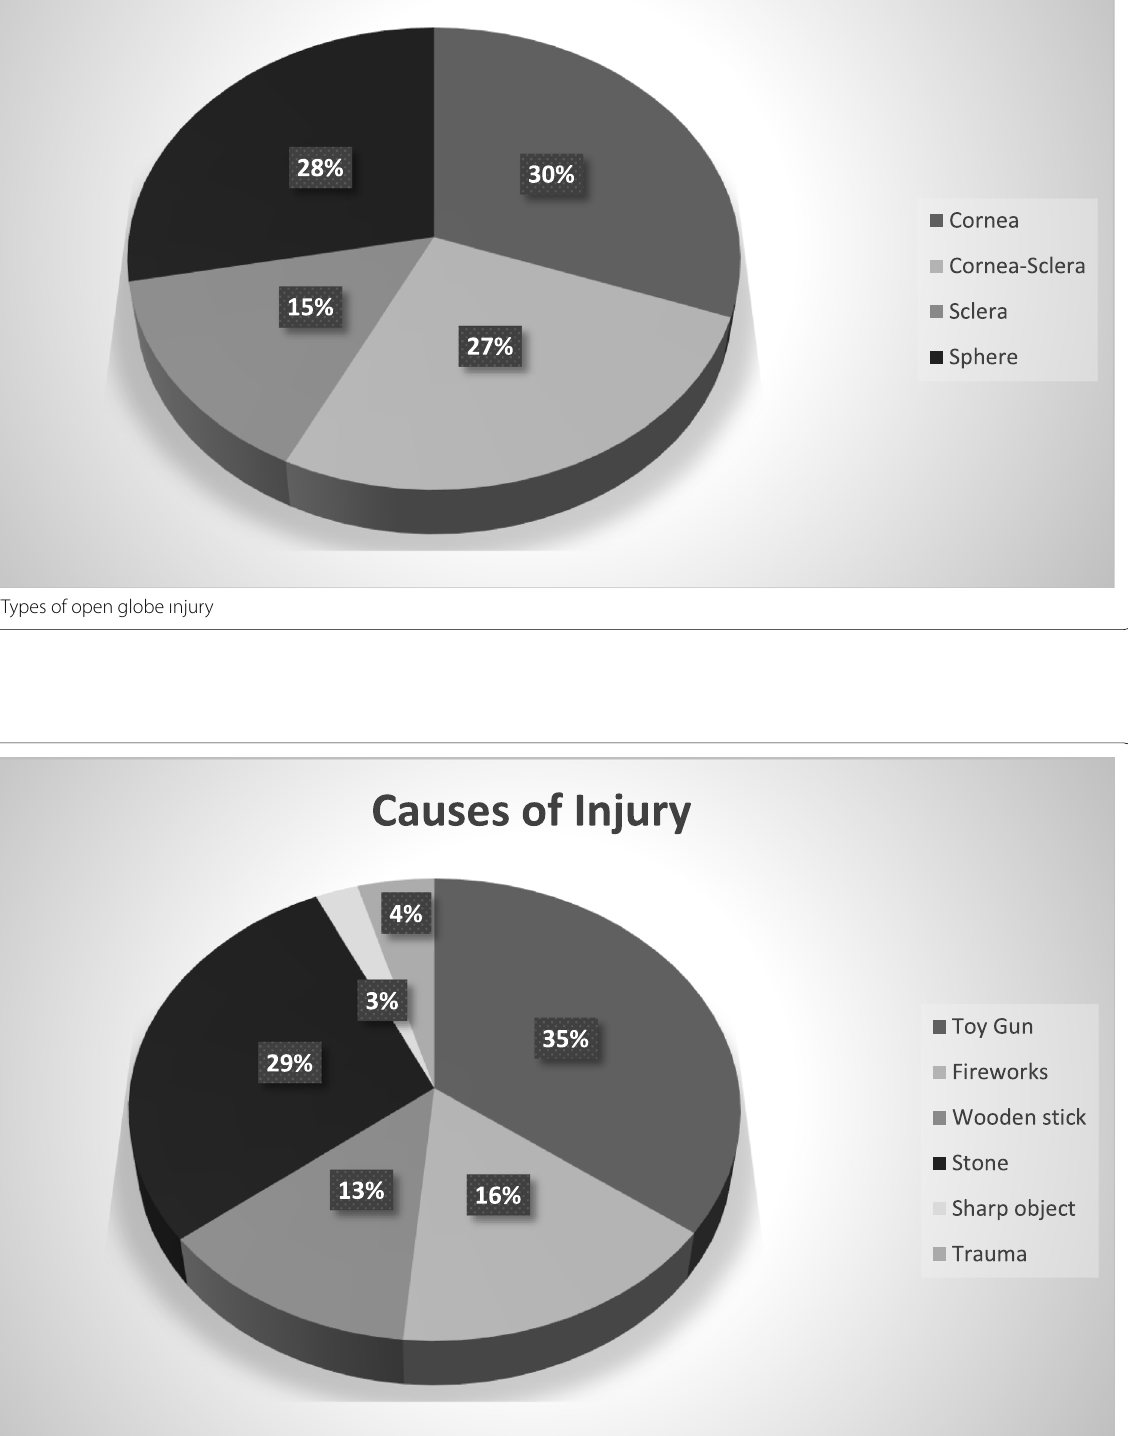
Fig. 3 Causes of